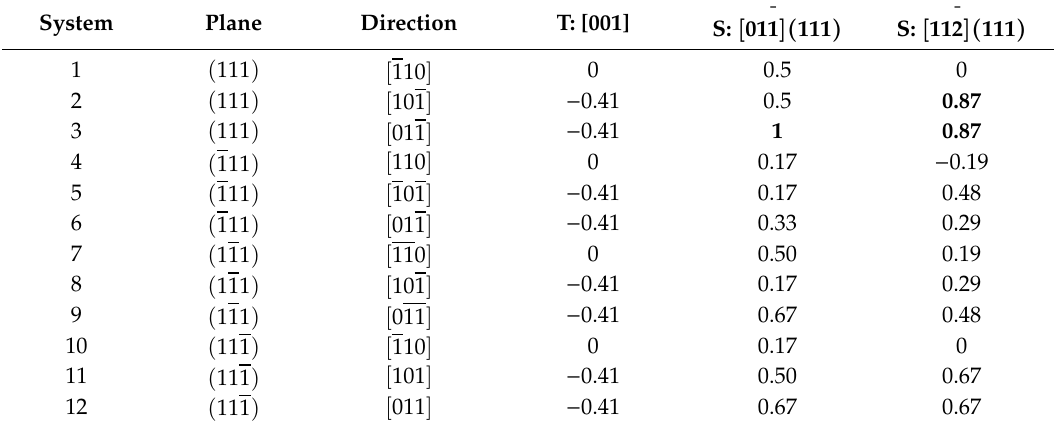
Table 5. Activation of twelve microscopic a / 2 (cid:104) 110 (cid:105) tensile testing (T) and shear creep testing (S) in the two macroscopic crystallographic shear systems [ 011 ]( 111 ) and [ 112 ]( 111 )